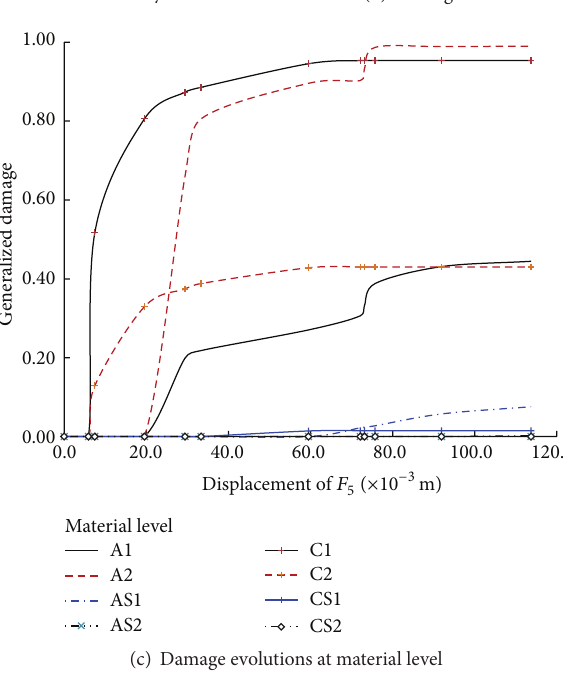
Figure 10: The calculated multilevel damage